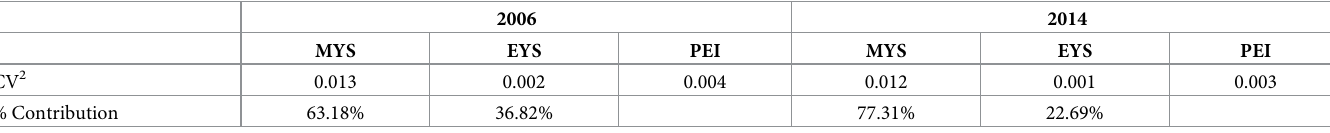
Table 3. Inequality in educational development and contribution of education